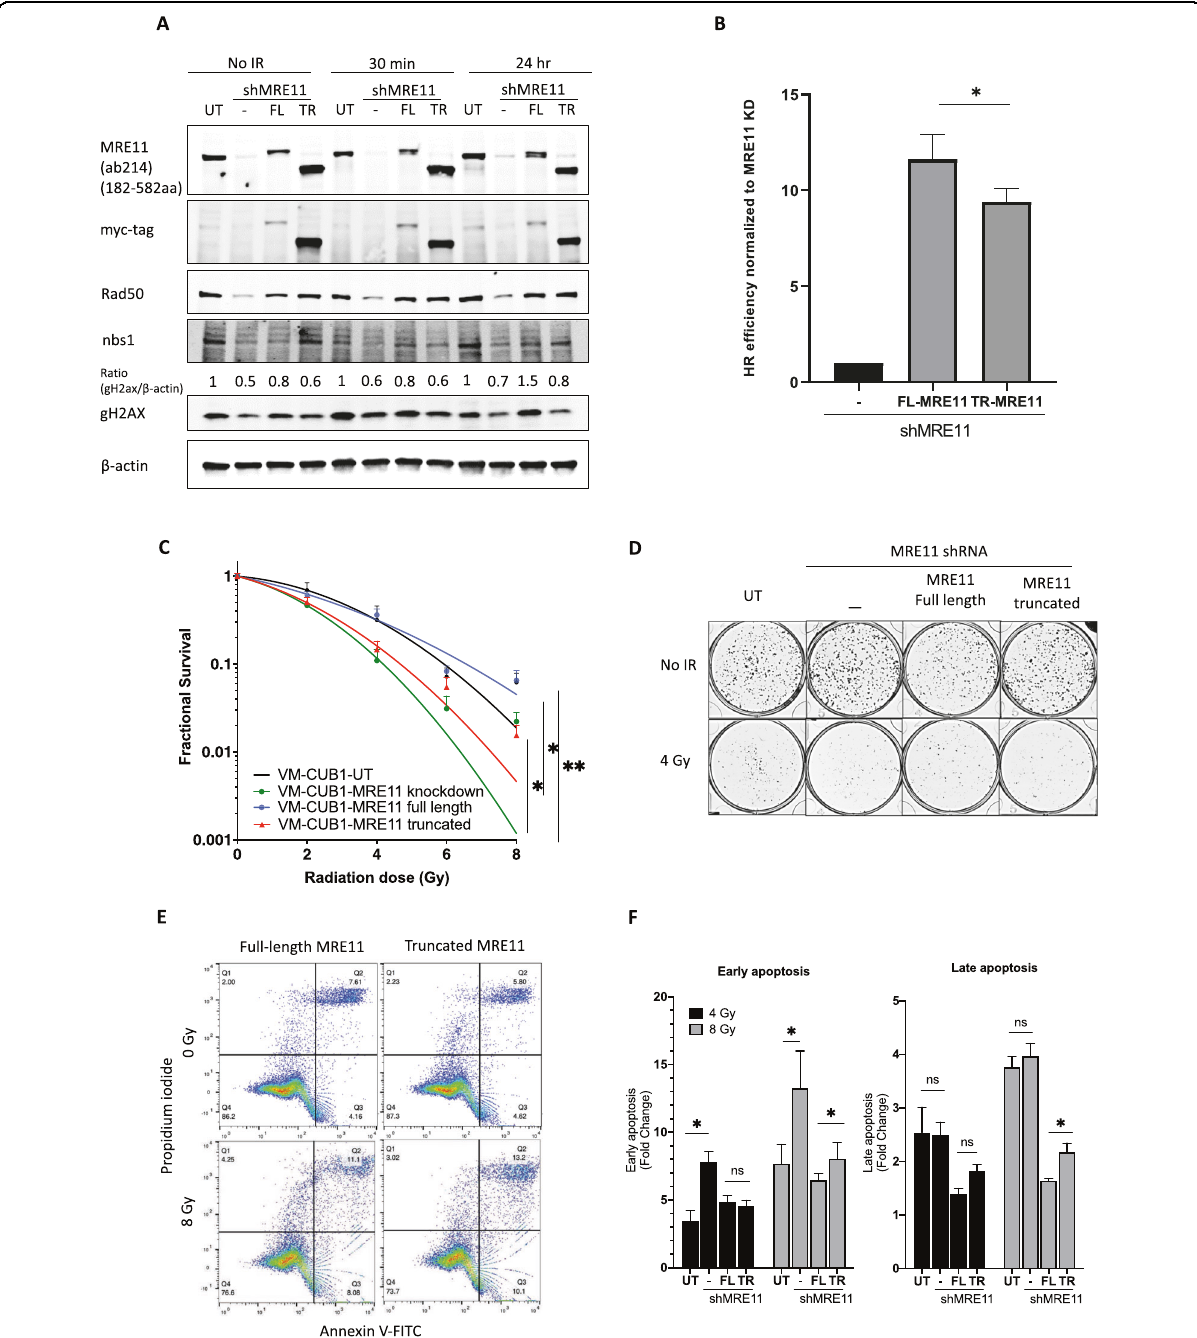
Fig. 5 Cells expressing TR-MRE11 are more radiosensitive and de fi ciency in HR repair than those expressing FL-MRE11. A The protein expression levels of the MRN complex subunits were unchanged after IR (2Gy). MRE11 KD and TR-MRE11 showed less increased level of γ H2AX compared to WT after IR. B GFP based reporter assay showing the ef fi ciency of HR repair pathway under FL-MRE11 or TR-MRE11 rescued condition as indicated. Graph represents the quanti fi cations from three independent experiments (* P <0.05; one-way ANOVA, n = 3, mean + SEM). C Clonogenic survival rates of TR- MRE11 and KD cells were lower than for FL-MRE11 and untreated cells. The response to ionising irradiation is represented by the linear-quadratic model. KD cells had signi fi cantly lower survival rate than UT cells ( P <0.05). TR-MRE11 cells had signi fi cantly lower survival rate than FL-MRE11 ( P <0.05) at 4Gy. D The representative image of ( C ). E Flow cytometric analysis results of various RT112 cells after 8Gy IR (48h). F A statistical plot of annexin V-FITC/PI staining for ( E ) is shown for both early and late apoptosis after 4 and 8Gy IR (48h). The results are expressed as the means±SD (****<0.0001, **<0.01, * P